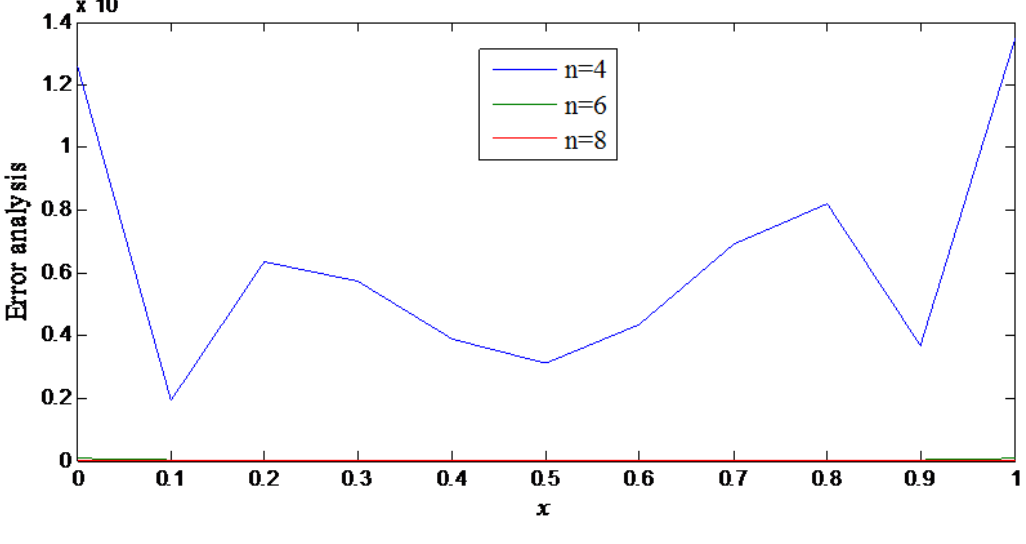
Fig. 2 Error analysis of Example